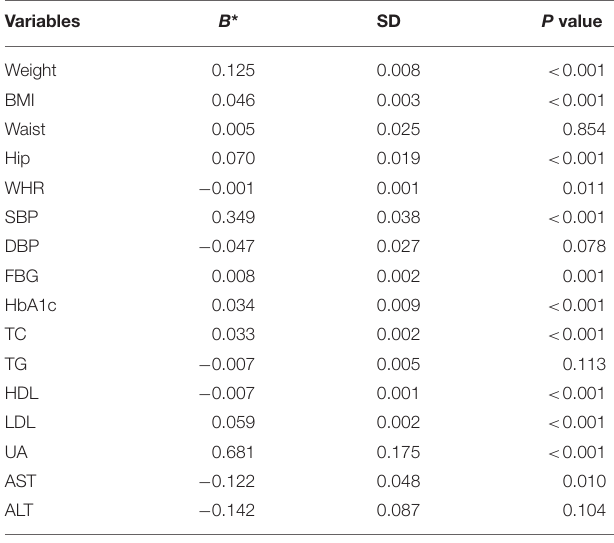
TABLE 3 | Multiple linear regression analysis exposure length of COVID-19 and paired changes of cardiometabolic markers. Variables